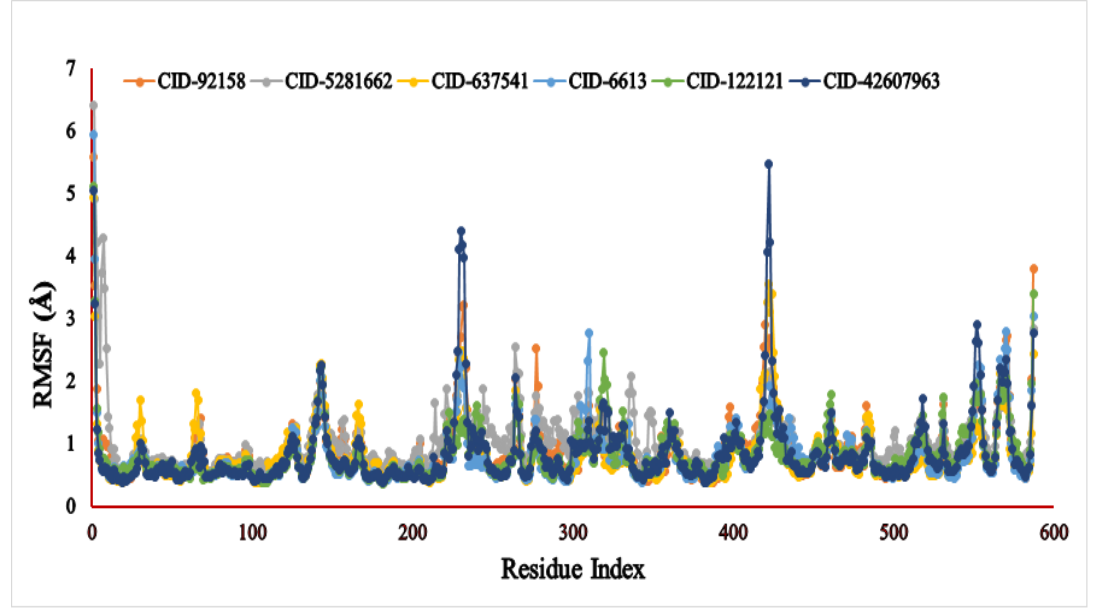
Figure 6. The RMSF values of the six selected compounds, viz., lupenone (CID: 92158), swertianolin (CID: 5281662), m -coumaric acid (CID: 637541), pantothenic acid (CID: 6613), phytosphingosine (CID: 122121), and 8- C -glucopyranosyleriodictylol (CID: 42607963), in association with the targeted protein α -glucosidase (PDB ID: 3A4A) are shown by specific colour.